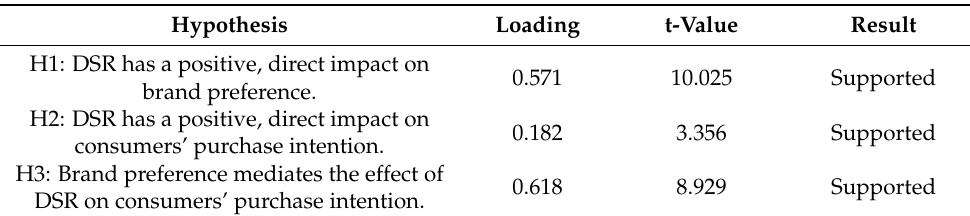
Table 4. Hypotheses